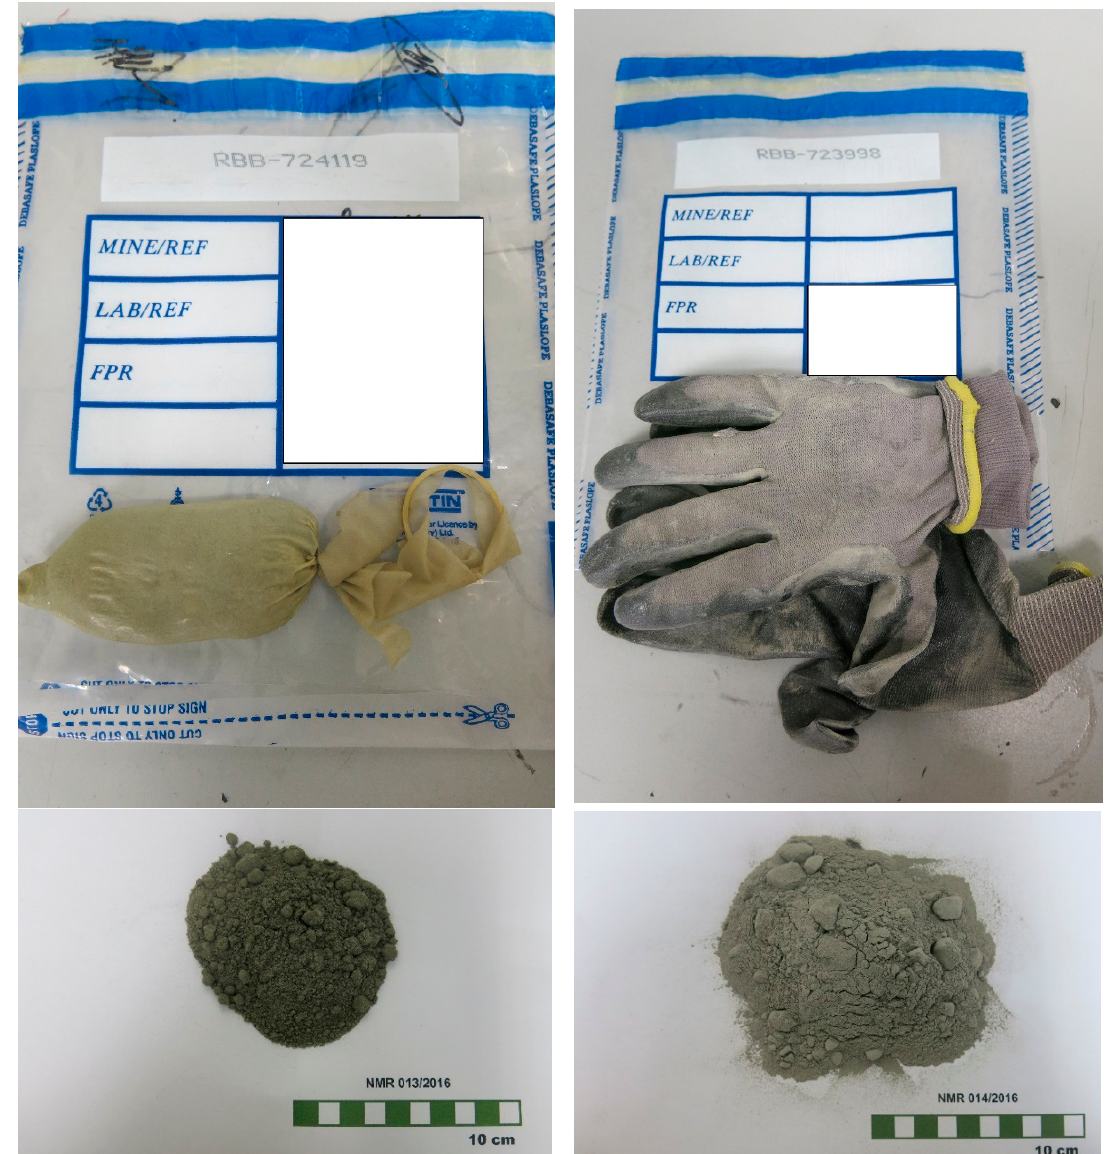
Figure 1. Photographs of material concealed in a condom and gloves—both parcels were confiscated at a platinum concentrator.